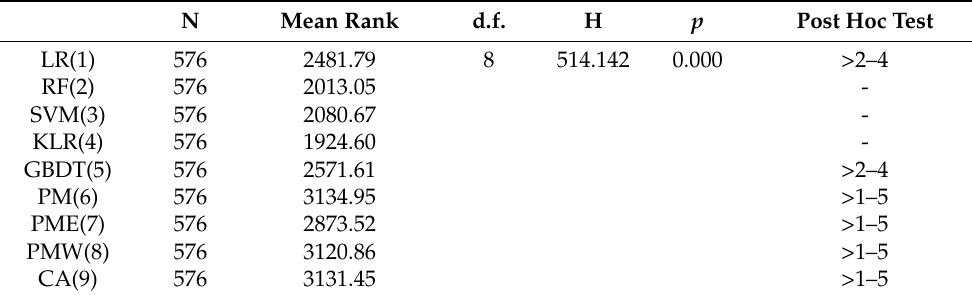
Table 11. Kruskal–Wallis test of the predictive accuracy of different modeling